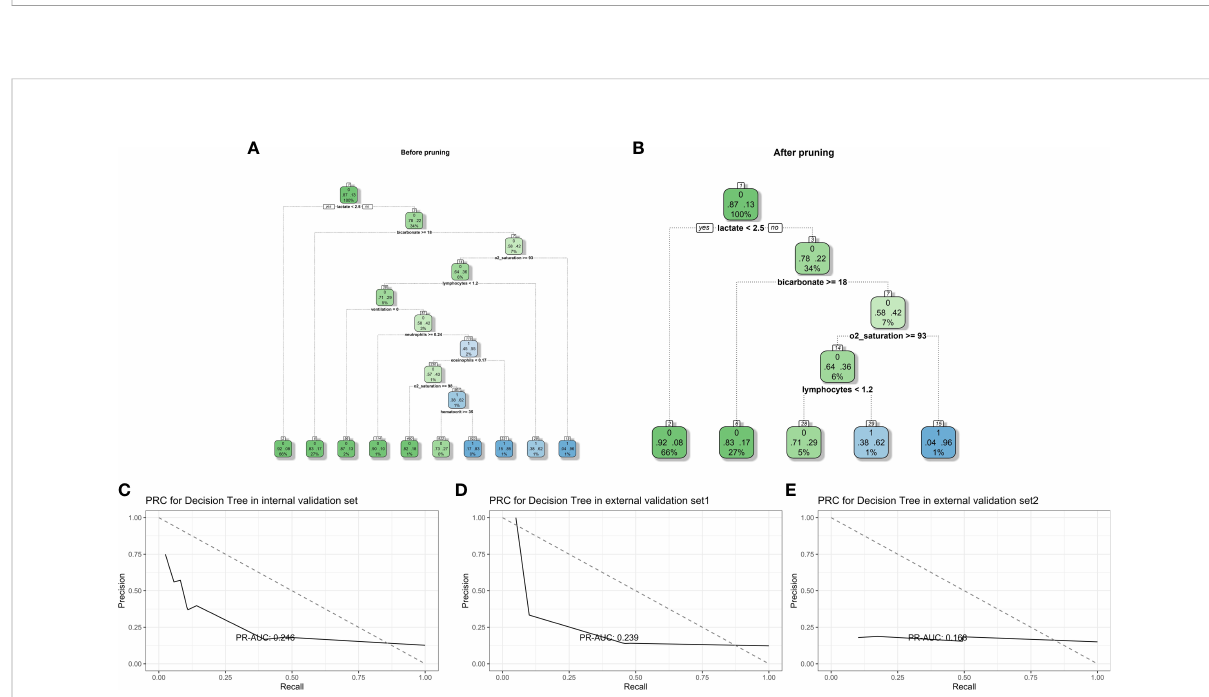
FIGURE 5 Decision tree model diagram before and after pruning (A, B) . PR-AUC for decision tree in the internal validation set, the external validation set 1, and the external validation set 2 [from (C – E) ].